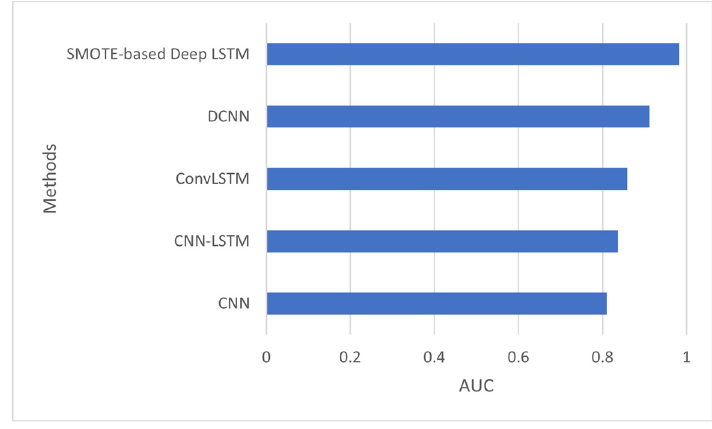
( d ) Figure 2. ( a ) Analysis based on TP Rate, ( b ) analysis based on FP Rate, ( c ) analysis based on preci- sion, and ( d ) analysis based on recall.